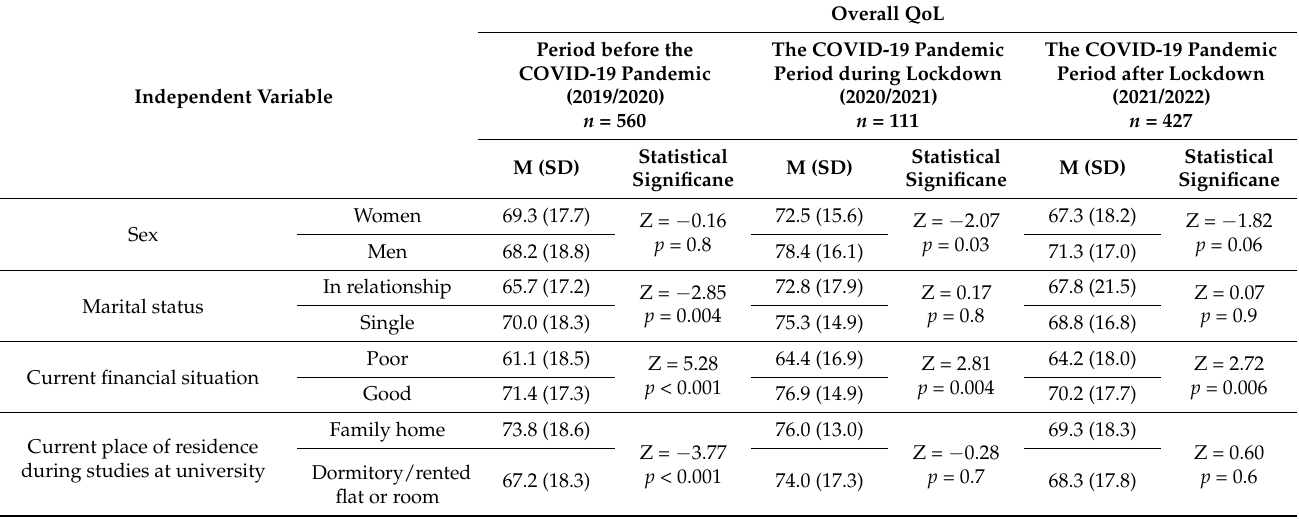
Table 3. Scoring for the Overall Quality of Life in medical students according to the study period and particular independent